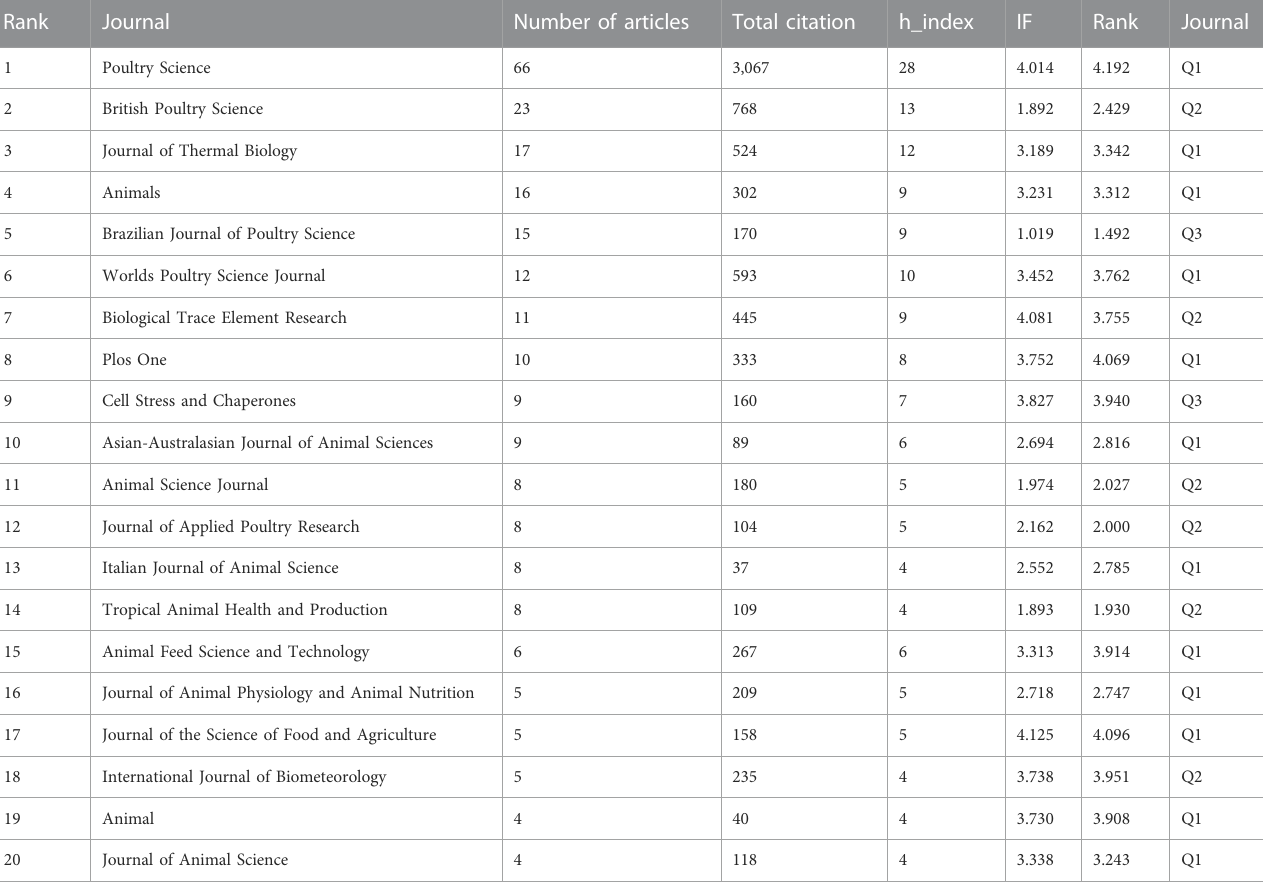
TABLE 3 Top 20 most productive journals contributing to research on heat stress in